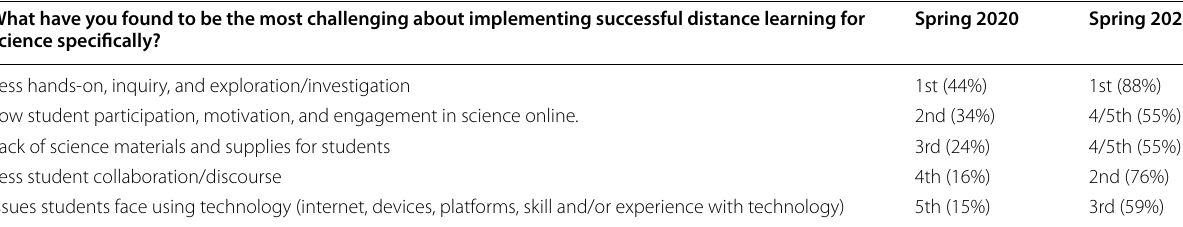
Table 3 Challenges to Teaching Science in K-8 Through Distance Learning: 2020 vs.